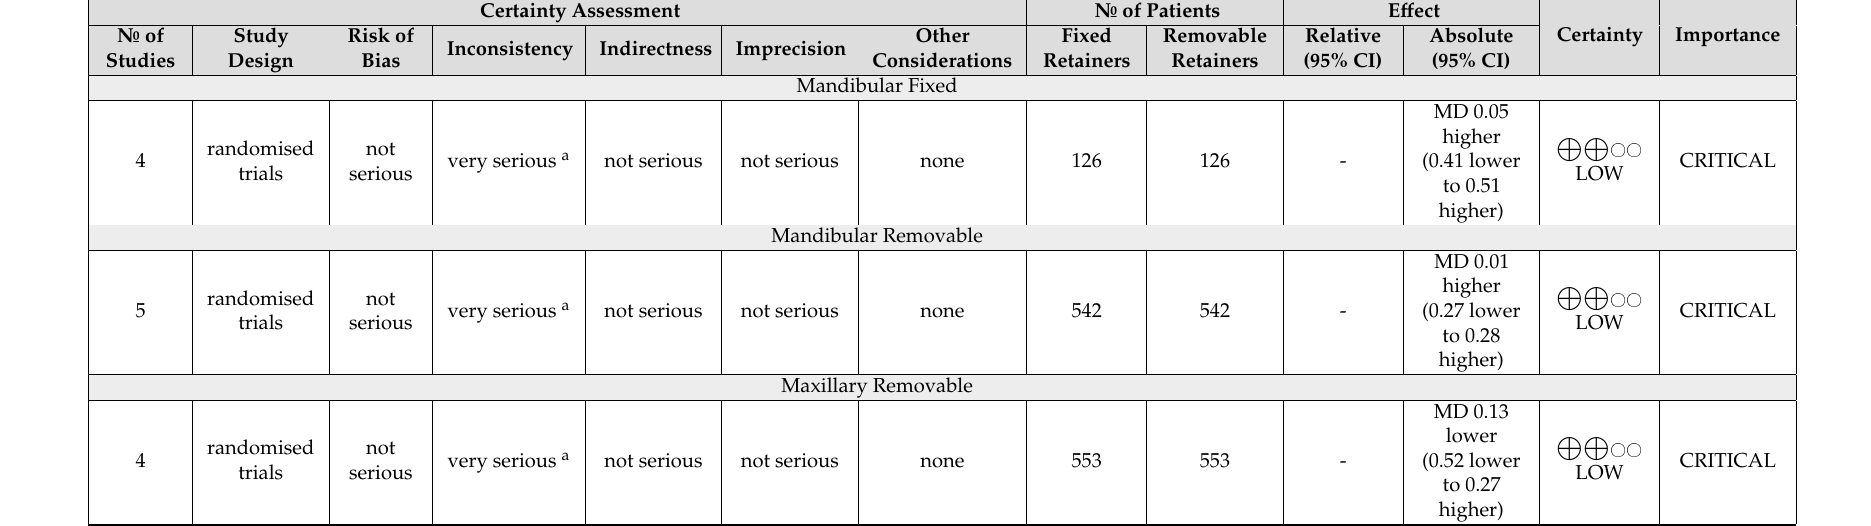
Table 6. Should fixed retainers or removable retainers be used for maintaining intercanine